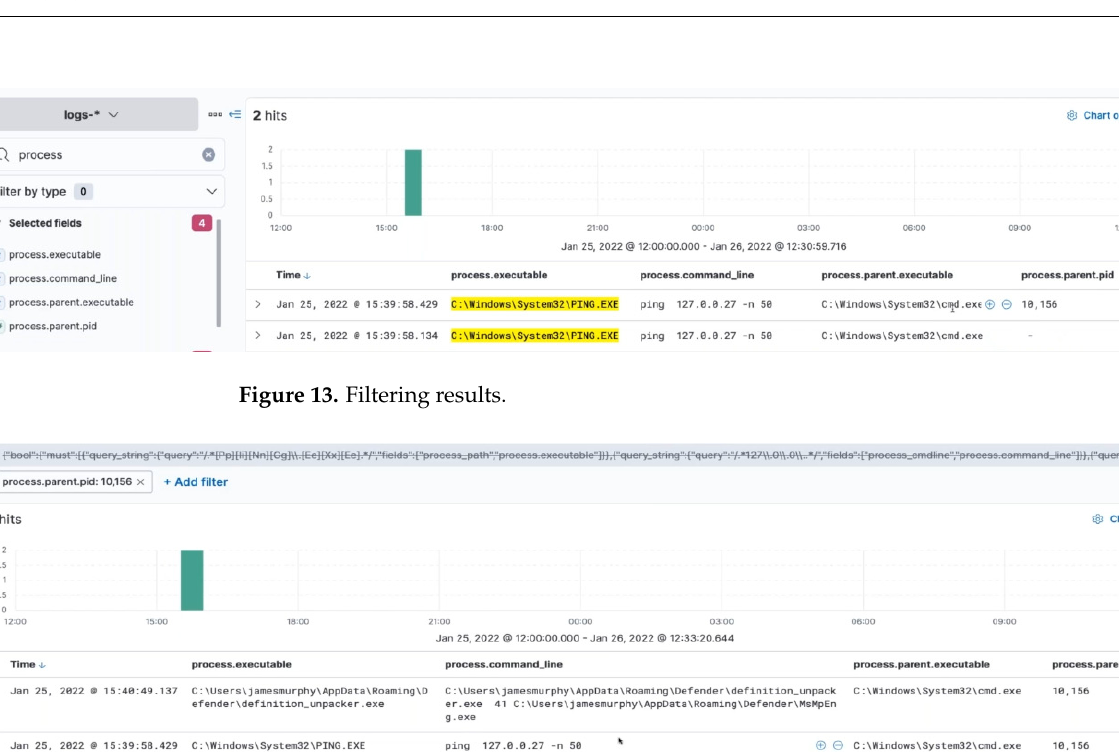
Figure 14. Process ID filtering results.